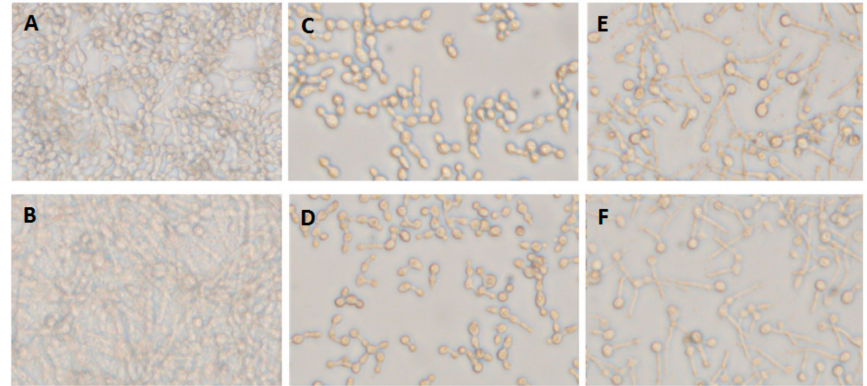
Figure 5. Dual inhibitory e ff ect of farnesol and carvacrol on single- and mixed-species C. albicans biofilm formation. ( A ) Single-species C. albicans, A5 biofilm formed after 24 h. ( B ) Mixed-species biofilm formed by C. albicans A5, P. stuartii 3, and S. aureus 6 (A5 / Ps3 / Sa6). ( C ) Single-species biofilm treated with farensol at 0.7 mg / mL in combination with carvacrol at 0.25 mg / mL. ( D ) Single-species biofilm treated with farensol at 0.7 mg / mL in combination with carvacrol at 0.5 mg / mL. ( E ) Mixed-species biofilm treated with farensol at 0.7 mg / mL in combination with carvacrol at 0.25mg / mL. ( F ) Mixed-species biofilm treated with farensol at 0.7 mg / mL in combination with carvacrol at 0.5 mg /